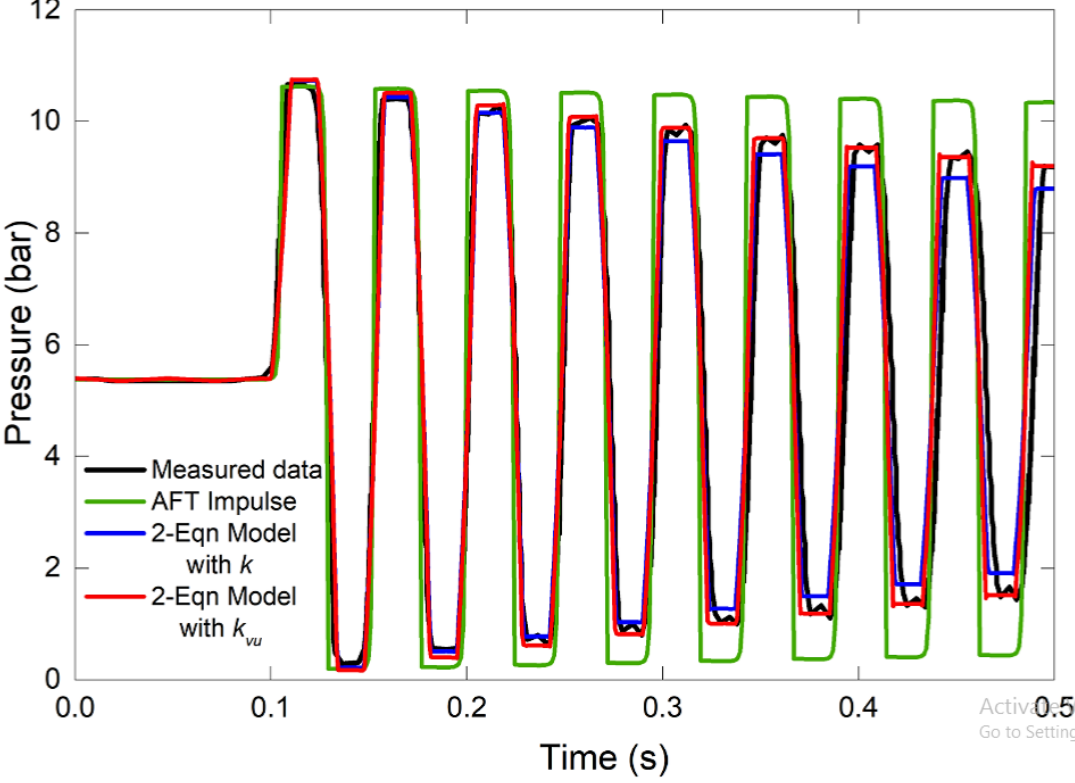
Figure 5. Transient pressure profiles for Soares’ experiment on copper pipe predicted by different models. The extra dissipation observed with a constant 𝑘 is rectified by using the variable 𝑘 Though the solution profiles obtained using 𝑘 a small phase shift is observed to develop between the numerical and the experimental profiles as the transient progress. This observation can be attributed to the variations in the signal speed